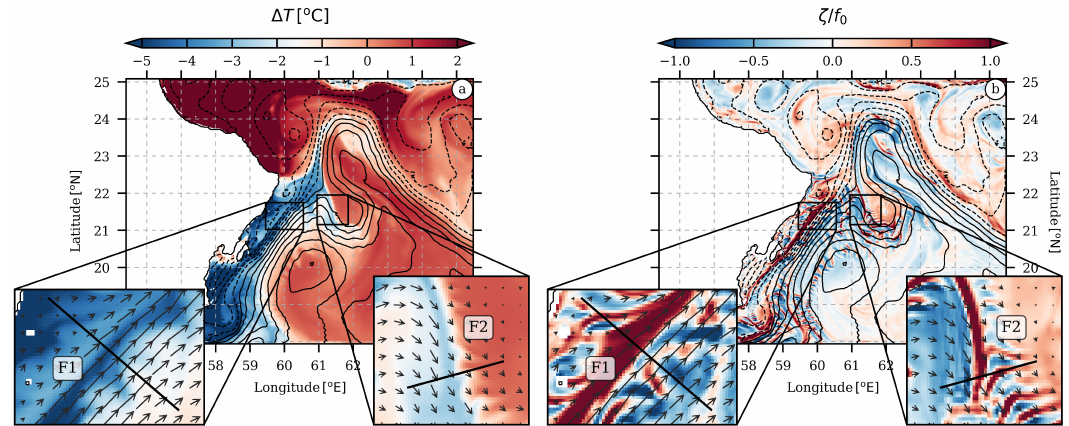
Figure 2. ( a ) Temperature anomaly and ( b ) surface relative vorticity normalized by the Coriolis frequency ( f 0 ) during the south-west monsoon at 10 m depth. Black contours stand for the sea surface height anomaly. Surface velocity vectors are represented in